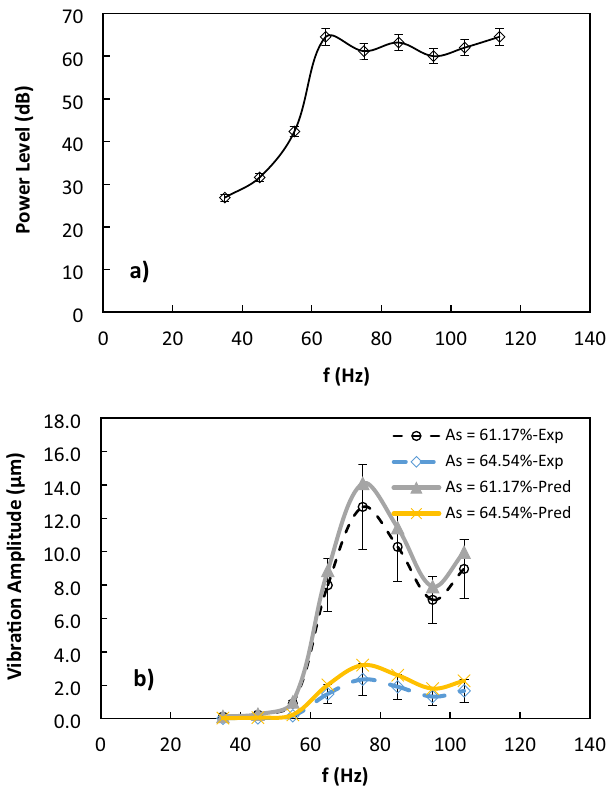
Figure 5. Variation of: ( a ) sonic power and ( b ) mesh screen displacement amplitude predicted and obtained from experiments with excitation